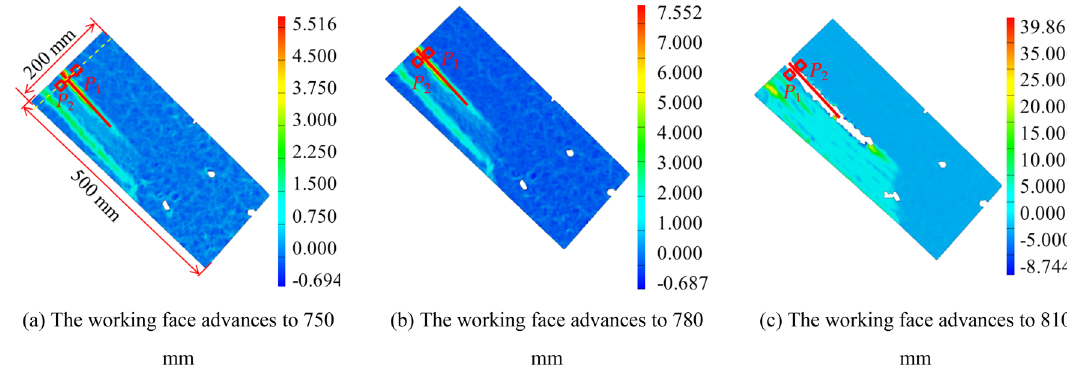
Figure 12. Layout of traditional method measuring